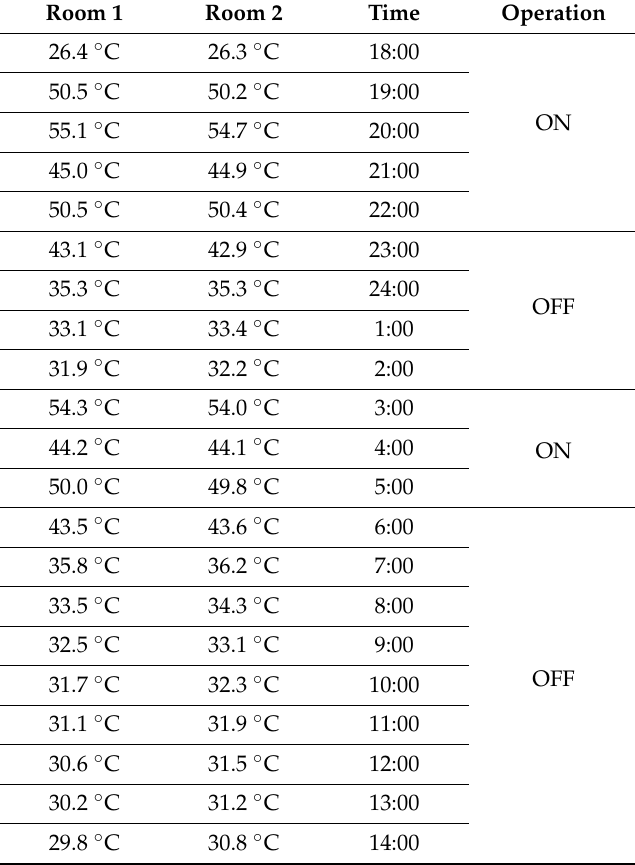
Figure 10. Hot water temperature on the surface of the pipe over time. Table 7. Temperature on the upper surface of the hot water pipe.